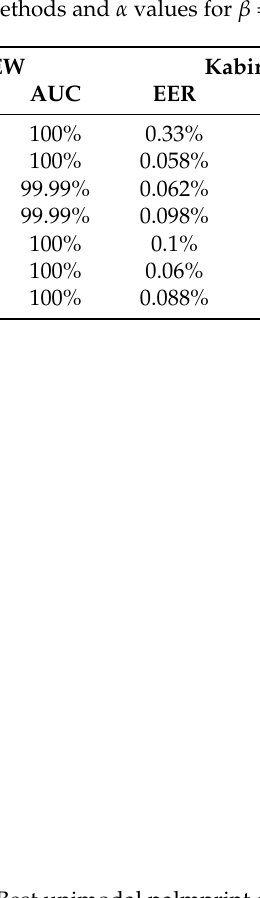
Table 5. EER and AUC values obtained using various fusion methods and α values for β = 5.